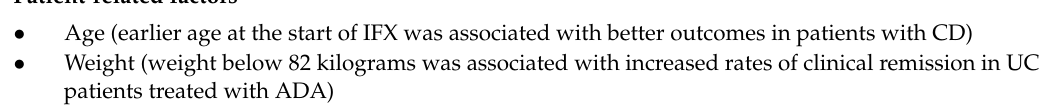
Table 2. Predictive factors of response to anti-TNF- α available in clinical